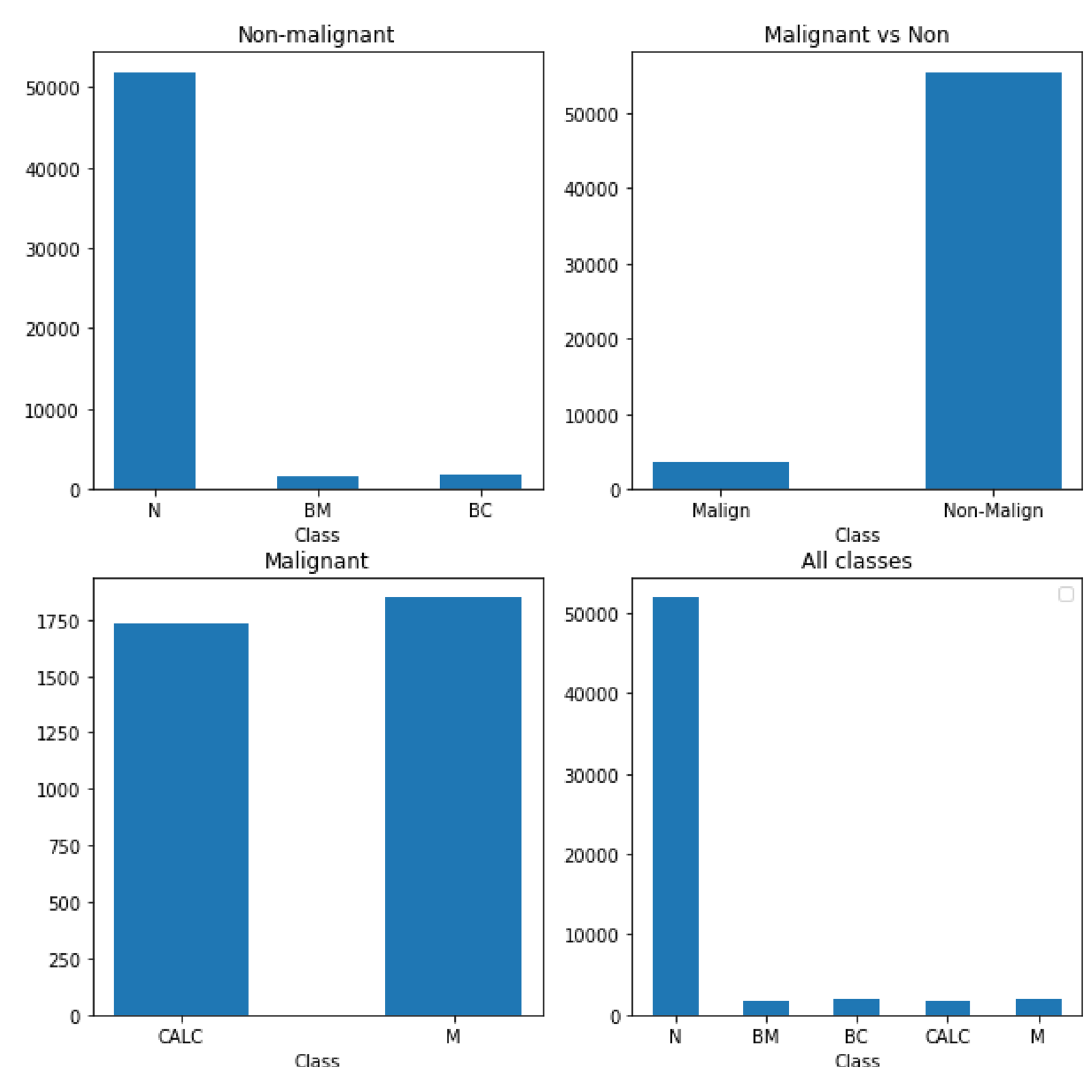
Figure 6. A graphical illustration of the distribution of image samples from the DDSM + CBIS and MIAS datasets. The distribution was graphed using the malignant and nonmalignant cases and further grouped according to the labelling as follows: BC benign calcification, BM benign mass, CALC calcification, M